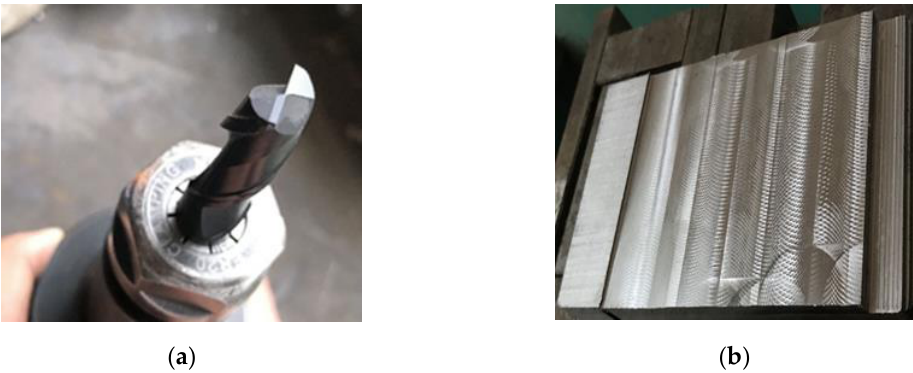
Figure 5. The milling tools and workpieces. ( a ) The two-edged flat end milling cutter. ( b ) The workpiece in the experiment.